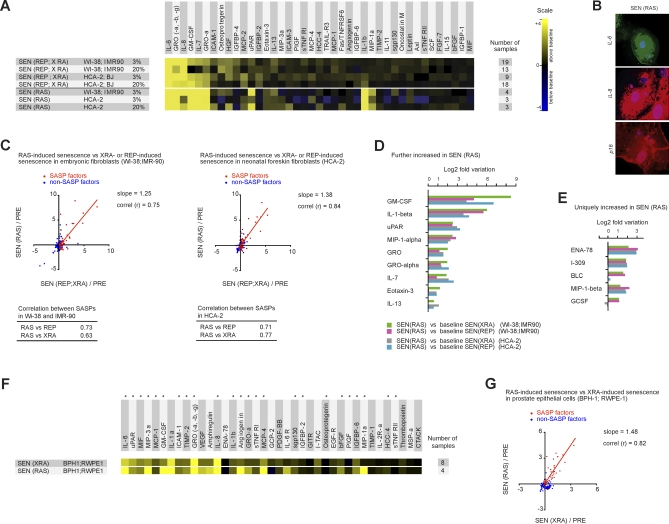
Oncogenic RAS Amplifies the SASP(A) Soluble factors produced by the indicated fibroblasts were analyzed by antibody arrays and displayed as described for Figure 1A, but in this case, PRE signals were used as the baseline. Therefore, color intensities represent log2-fold changes of SEN CM relative to PRE CM from cells of the same genotype under the same culture conditions. We pooled and averaged highly correlated data (see Figure 1C) from cells originating from a common tissue (WI-38, IMR-90 from embryonic lung; and HCA-2, BJ from neonatal foreskin), and from senescence induced by REP or XRA. Details of the data processing are provided in Datasets S9–S12. The senescence inducer is given in parentheses. Signals higher than baseline are shown in yellow; signals below baseline are displayed in blue. The numbers on the heat map key (right) indicates log2-fold changes from the baseline.(B) WI-38 cells induced to senesce by RAS were immunostained for the SASP proteins IL-6 and IL-8, and the senescence marker p16INK4a.(C) Correlations between SASPs induced by RAS versus REP or XRA in fibroblasts from embryonic lung (WI-38, IMR-90, left) or neonatal foreskin (HCA-2, right). Correlations for the individual cell strains and senescence inducers are given in the tables below the graphs.(D) Shown are the log2-fold values for factors that are significantly increased in CM from fibroblasts induced to senesce by RAS compared to fibroblasts induced to senesce by XRA or REP. Green indicates SEN WI-38 and IMR-90 cells induced to senesce by RAS versus XRA. Red indicates SEN WI-38 and IMR-90 induced to senesce by RAS versus REP. Gray indicates HCA2 cells induced to senesce by RAS versus XRA. Blue indicates HCA2 cells induced to senesce by RAS versus REP.(E) Shown are the log2-fold values for factors that are uniquely and significantly increased in CM from fibroblasts induced to senesce by RAS compared to PRE CM, but not significantly changed in CM from fibroblasts induced to senesce by XRA or REP. The color code is identical to (D).(F) Soluble factors from CM produced by the indicated epithelial cells were analyzed by antibody arrays and displayed as described for Figure 1A, using PRE CM as the baseline. Signals higher than baseline are shown in yellow; signals below baseline are in blue. Asterisks (*) indicate factors conserved between fibroblasts and epithelial cells.(G) Correlations between SASPs induced by RAS versus XRA in prostate epithelial cells.